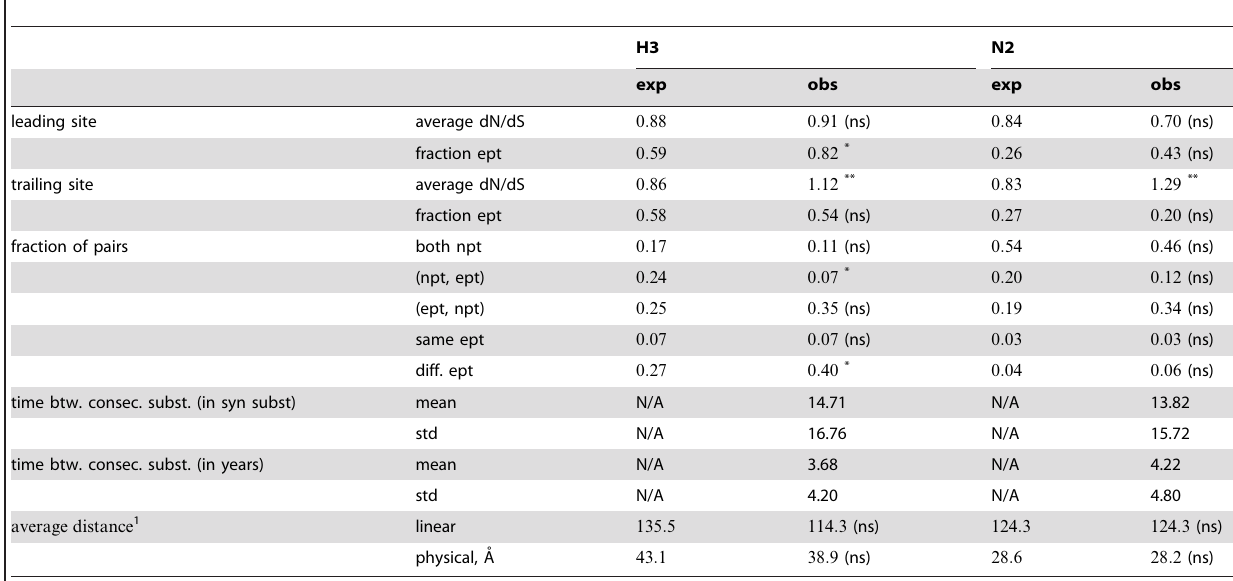
P - values are obtained from two-tailed tests, except for the last two rows which report one-sided tests regarding distances between sites. Single and double asterisks denote significance at 0.05 and 0.01 level, respectively; ‘‘ns’’, ‘‘ept’’, ‘‘npt’’, ‘‘obs’’, ‘‘exp’’, and ‘‘N/A’’ denote not significant, epitopic, non-epitopic, observed, expected, and not applicable respectively. 1 Average distances are computed only over those significant pairs in which both residues are present in the crystal structure (see ‘‘Materials and Methods’’).